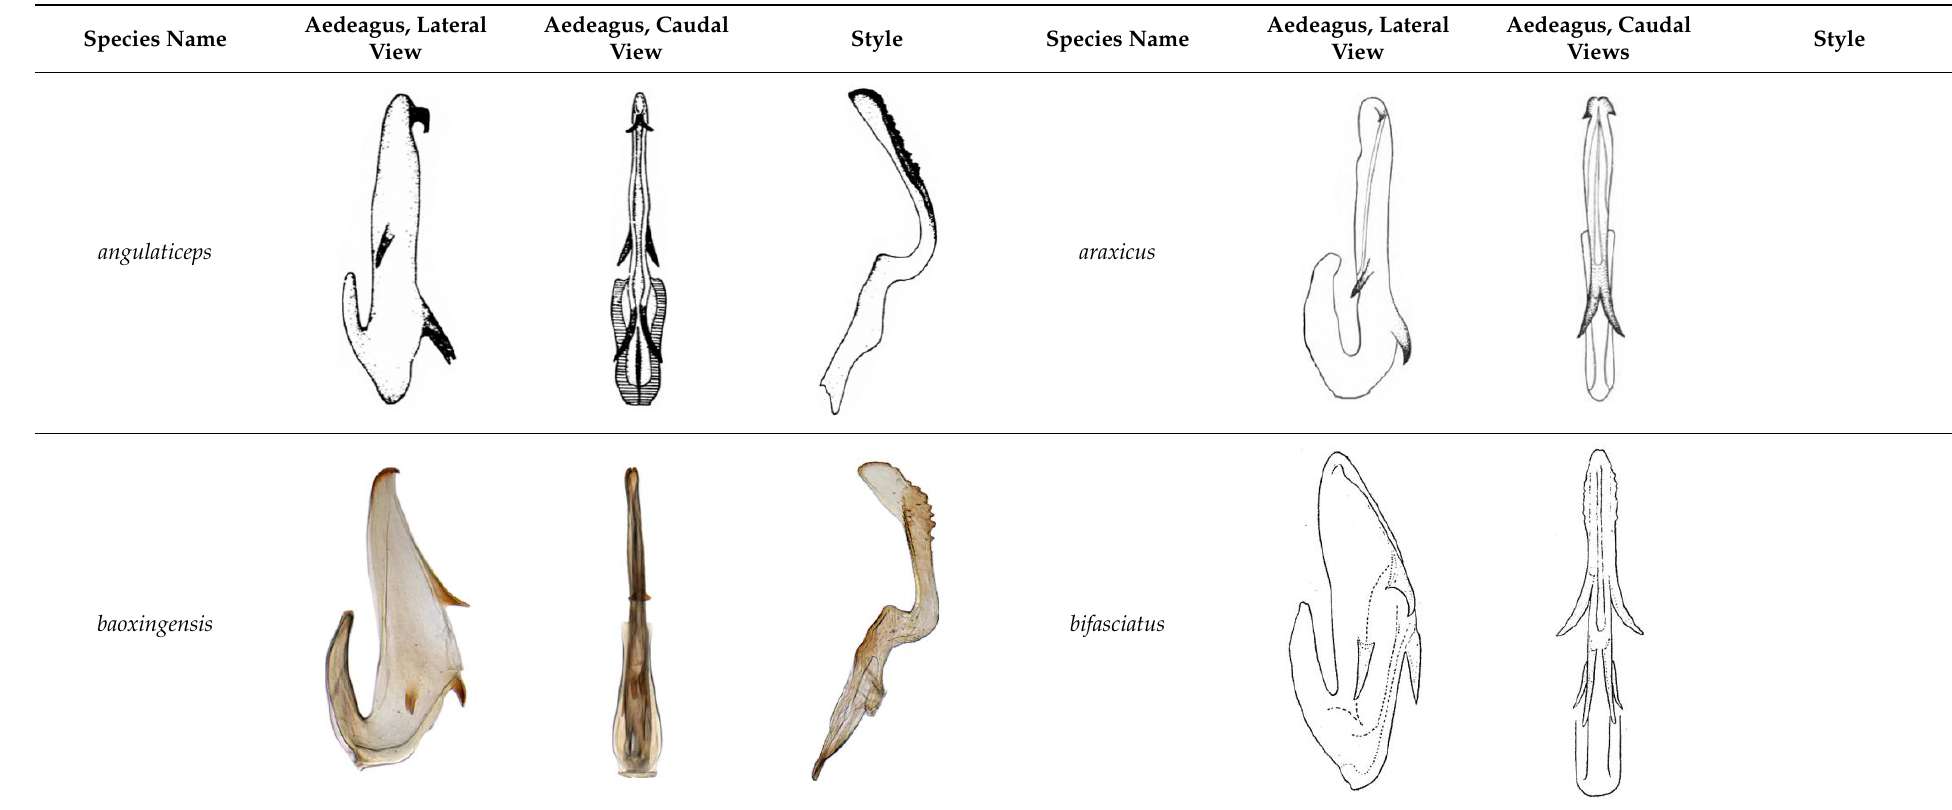
Table 2. Comparative morphology of Aedeagus and style of Planaphrodes (the styles of some species were not provided in the references).